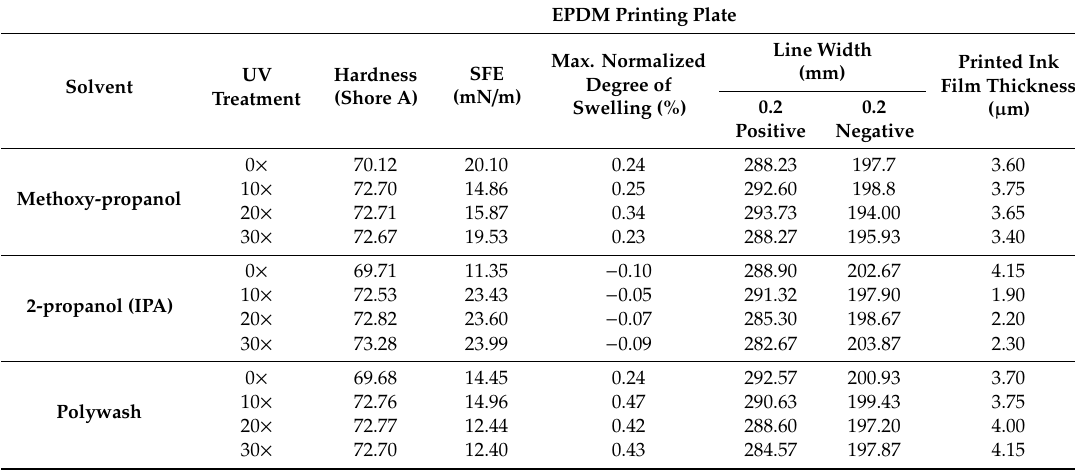
Table 3. Summary of results obtained with EPDM printing